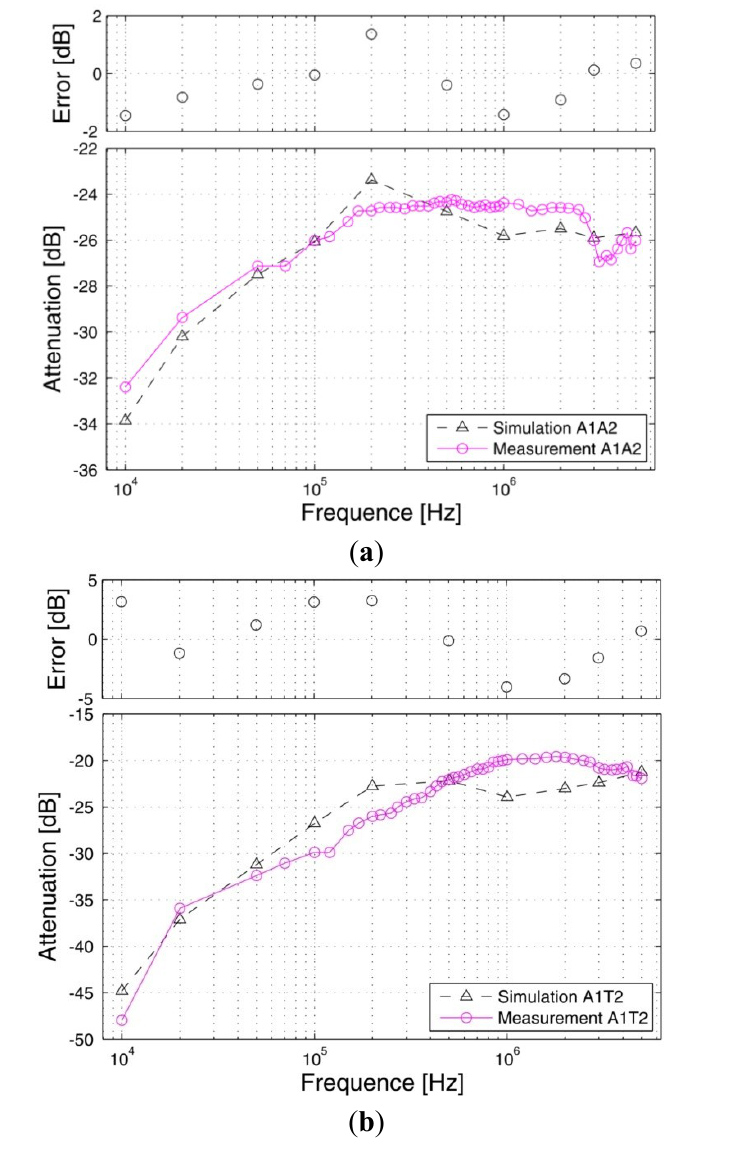
Figure 9. The simulation results and the measurement results of the A1A2 path ( a ), the A1T2 path ( b ) and the A1H1 path ( c